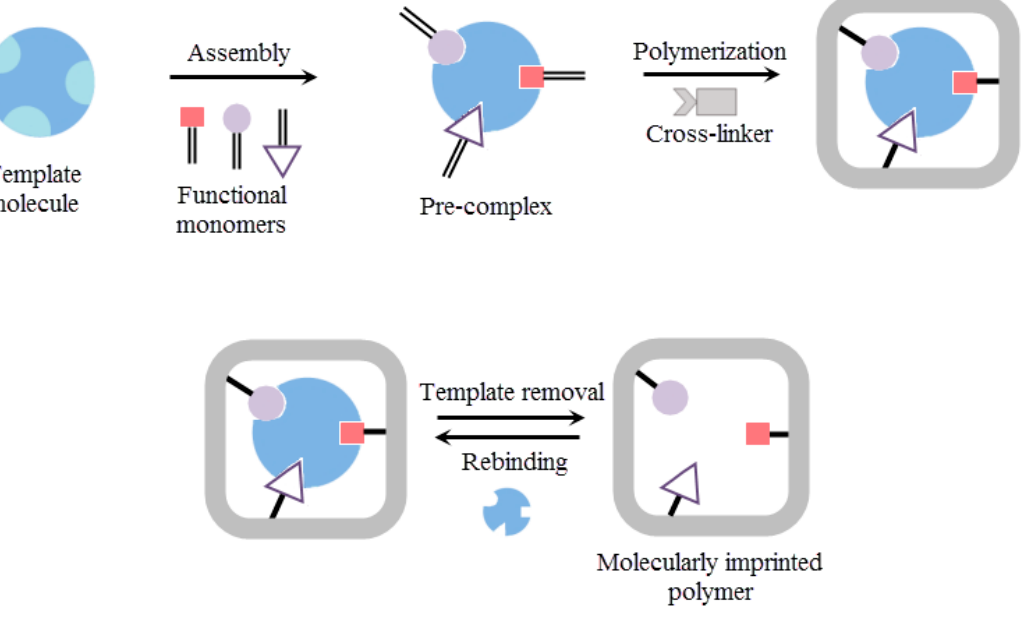
Figure 1. Scheme of the principle of molecularly imprinted polymer preparation.